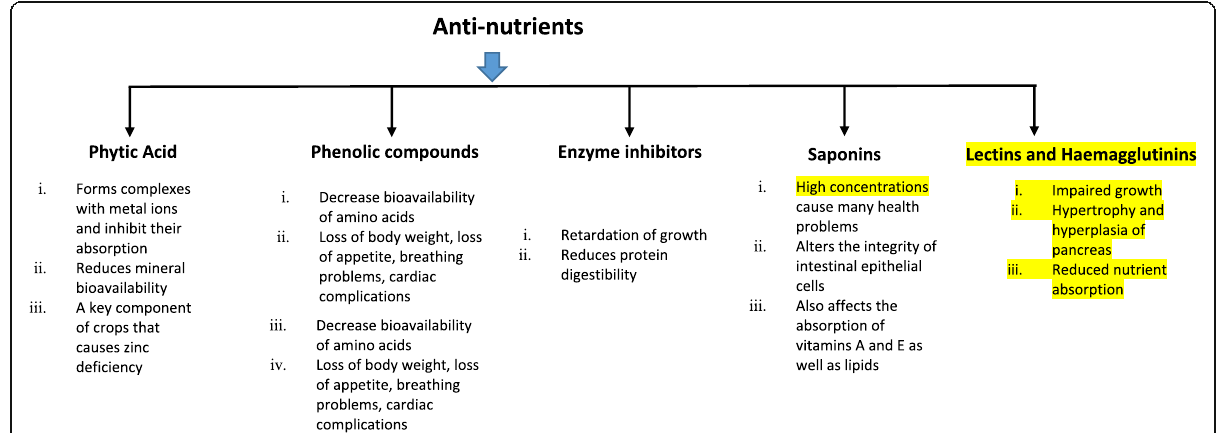
Fig. 1 A brief overview of the adverse effects of key anti-nutrients (Schlemmer et al. 2009; Wilson et al. 1981; Gemede and Ratta 2014; Jansman et al. 1998; Muramoto